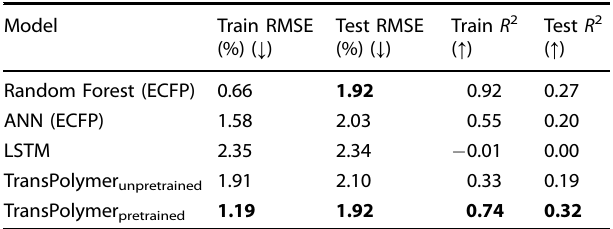
Table 5. Performance of TransPolymer and baseline models on p-type polymer OPV. Model